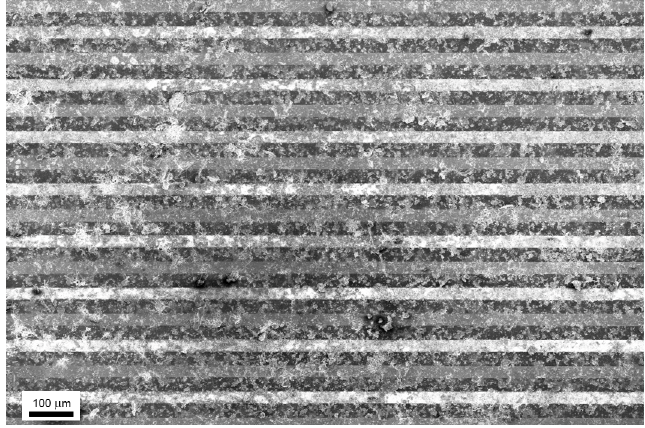
Figure 7. SEM image of sensor obtained by drop casting exfoliated WS 2 and annealing at 180 °C on Si 3 N 4 substrate provided with Pt finger-type electrodes (30 microns apart).